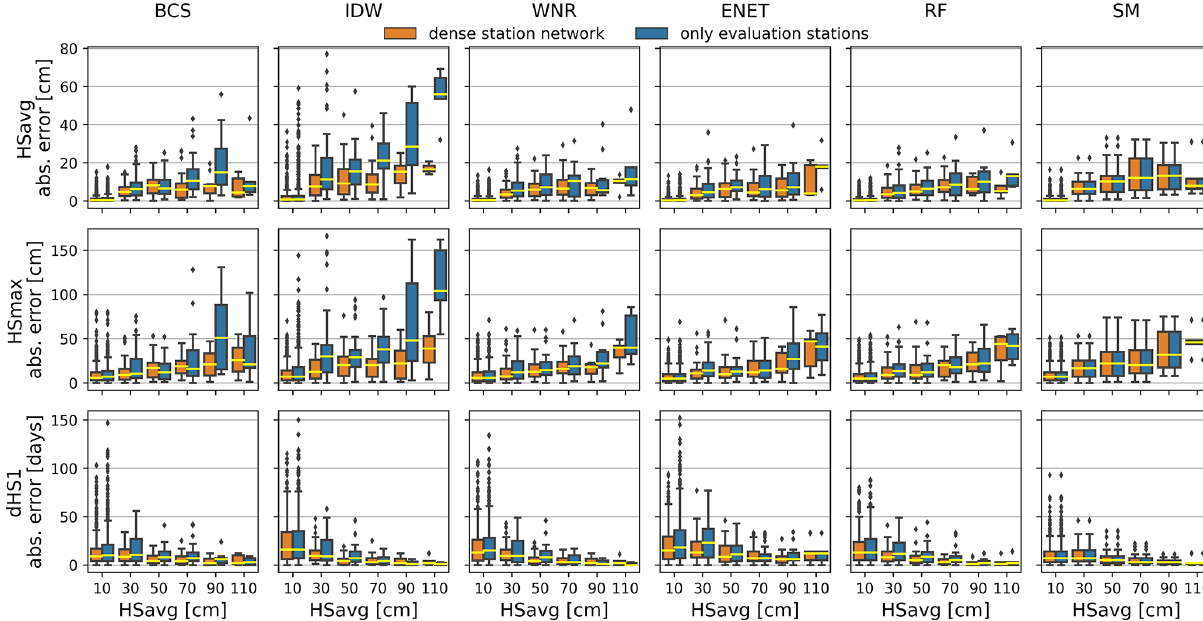
Figure 5. Box plots of absolute errors in average snow depth in a winter (HSavg, top row), maximum snow depth in a winter (HSmax, middle row) and number of snow days with HS ≥ 1cm (dHS1, bottom row) calculated for 20cm HSavg bins of the respective gap winter and the different methods (columns). Colors of the box plots denote the different station networks that have been used for reconstruction. Outliers in the box plots are not shown for better comparison. Table 3. Suitability of different methods in different situations (dense and sparse station networks, gaps in neighboring stations) and for different applications. Suitability ranges from not recommended or not possible ( −− ) to very good ( ++